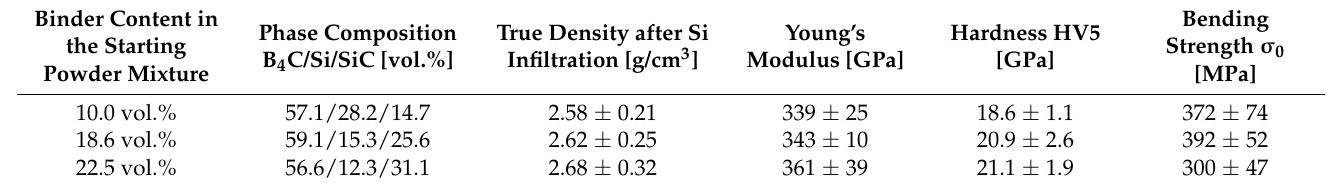
Table 1. Density, phase composition, and mechanical properties of reaction-bonded B 4 C samples with different binder content in the starting powder